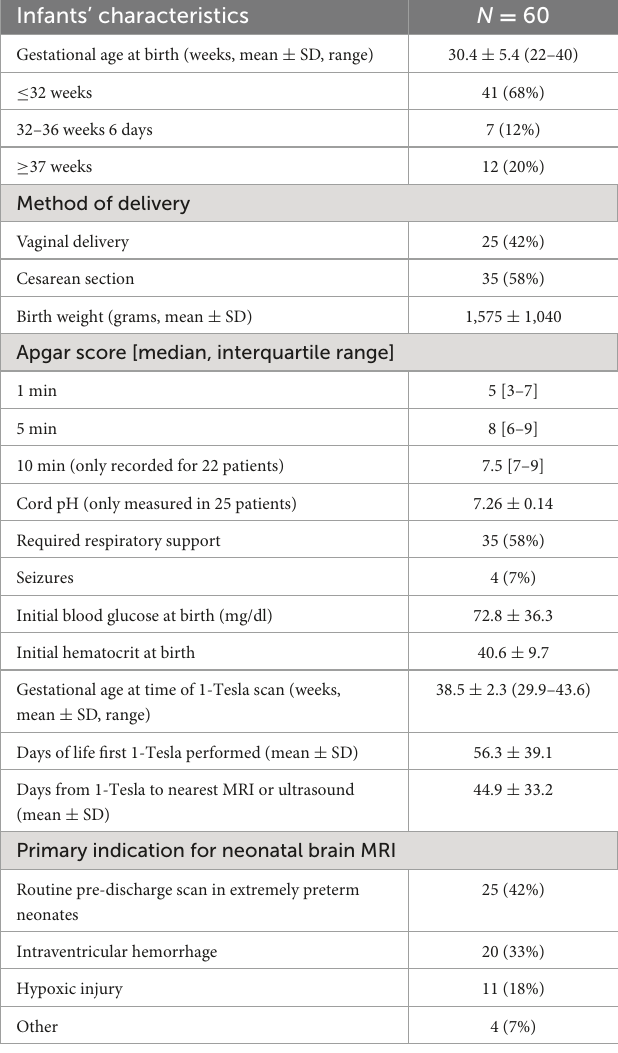
TABLE 1 Demographic characteristics of infants who had 1-Tesla brain